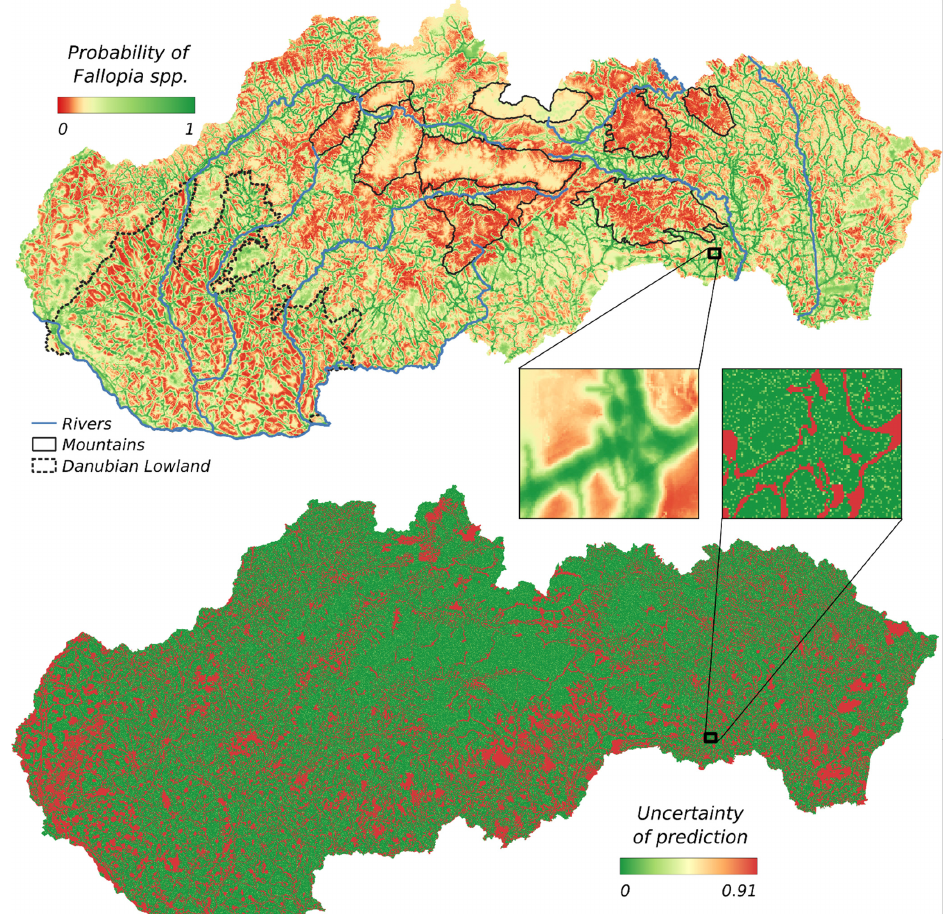
Figure 1. The ensemble prediction model of Fallopia species., with selected components and the uncertainty of a prediction. Selected components represent geomorphological units with relative homogenetic Fallopia species predictions.